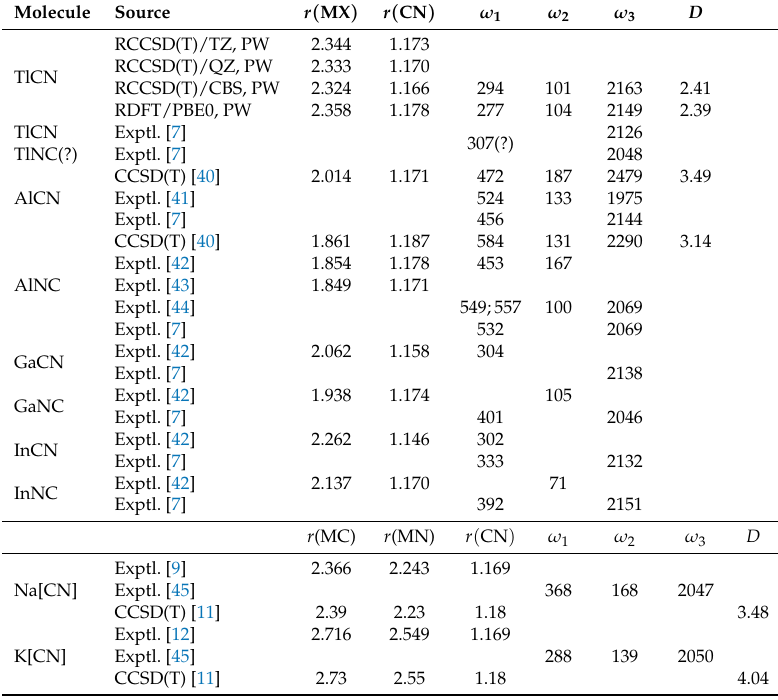
Table 2. Molecular parameters of M · CN isomers for M belonging to groups 13 and 1. Internuclear distances in ångstroms, vibrational frequencies ( ω ) in cm − 1 , dipole moments ( D ) in atomic units, r ( MX ) = r ( MC ) for cyanides and r(MN) for isocyanides. PW: present work. Molecule